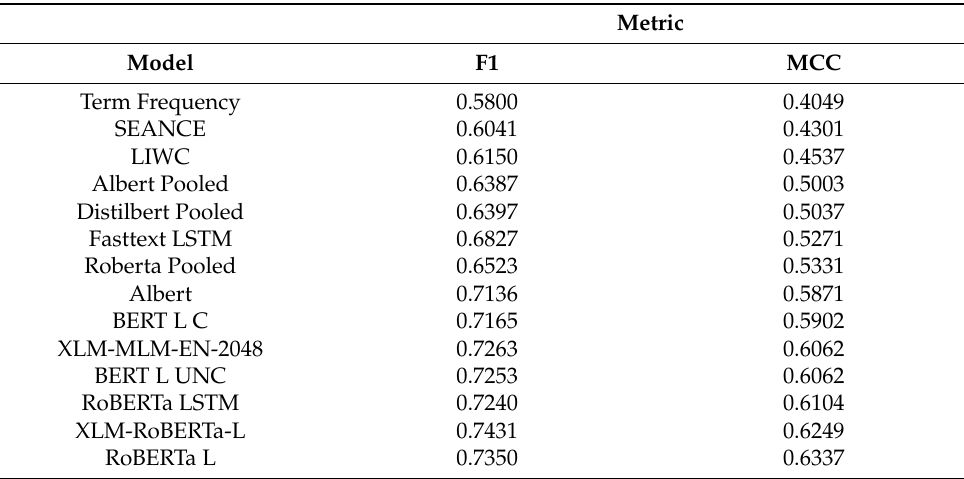
Figure 1. Matrix of correlations between annotators regarding respectfulness of data instances (“AN1,” “AN2,” and “AN3”) and sentiment (“SENT”) labels provided in the original data set. Table 3. F1 macro and MCC scores of the compared models.